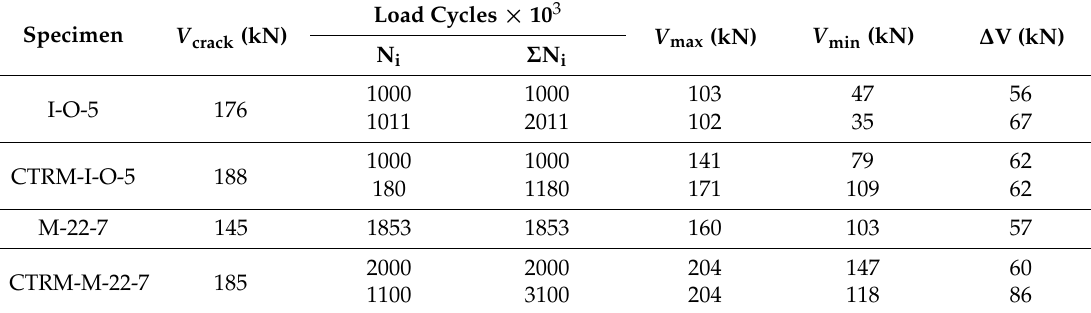
Table 7. Number of load cycles and amplitudes.